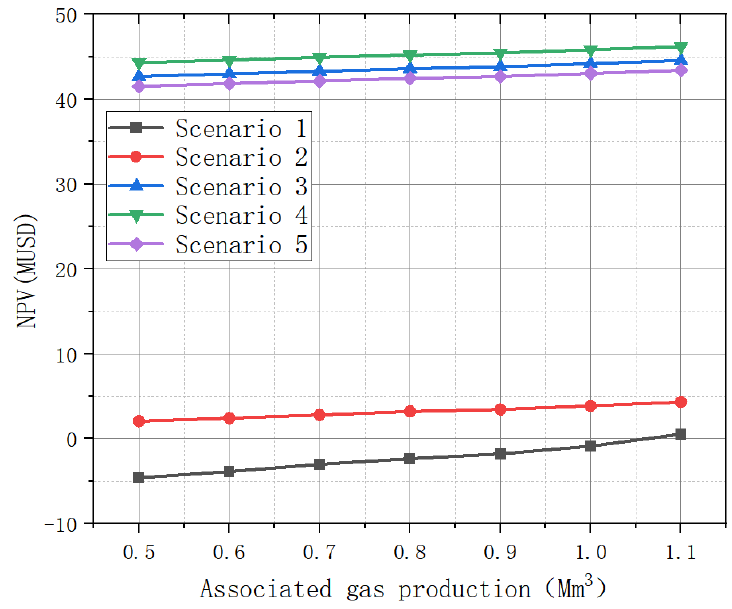
Figure 12. NPV of associated gas production under different scenarios .